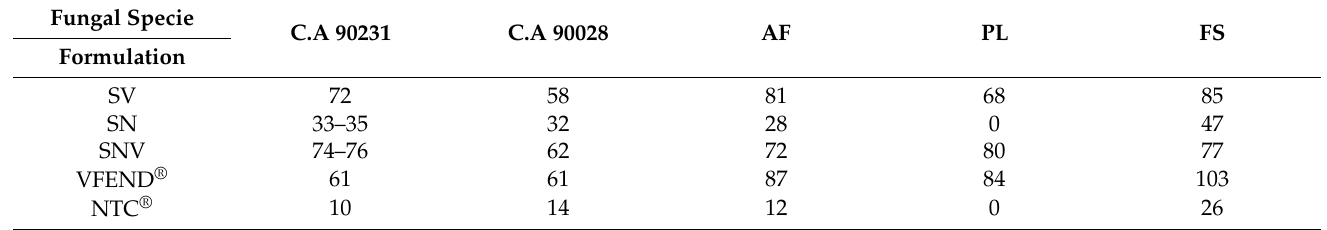
Table 9. Inhibition zone diameters (mm) obtained in Kirby–Bauer Disc Diffusion